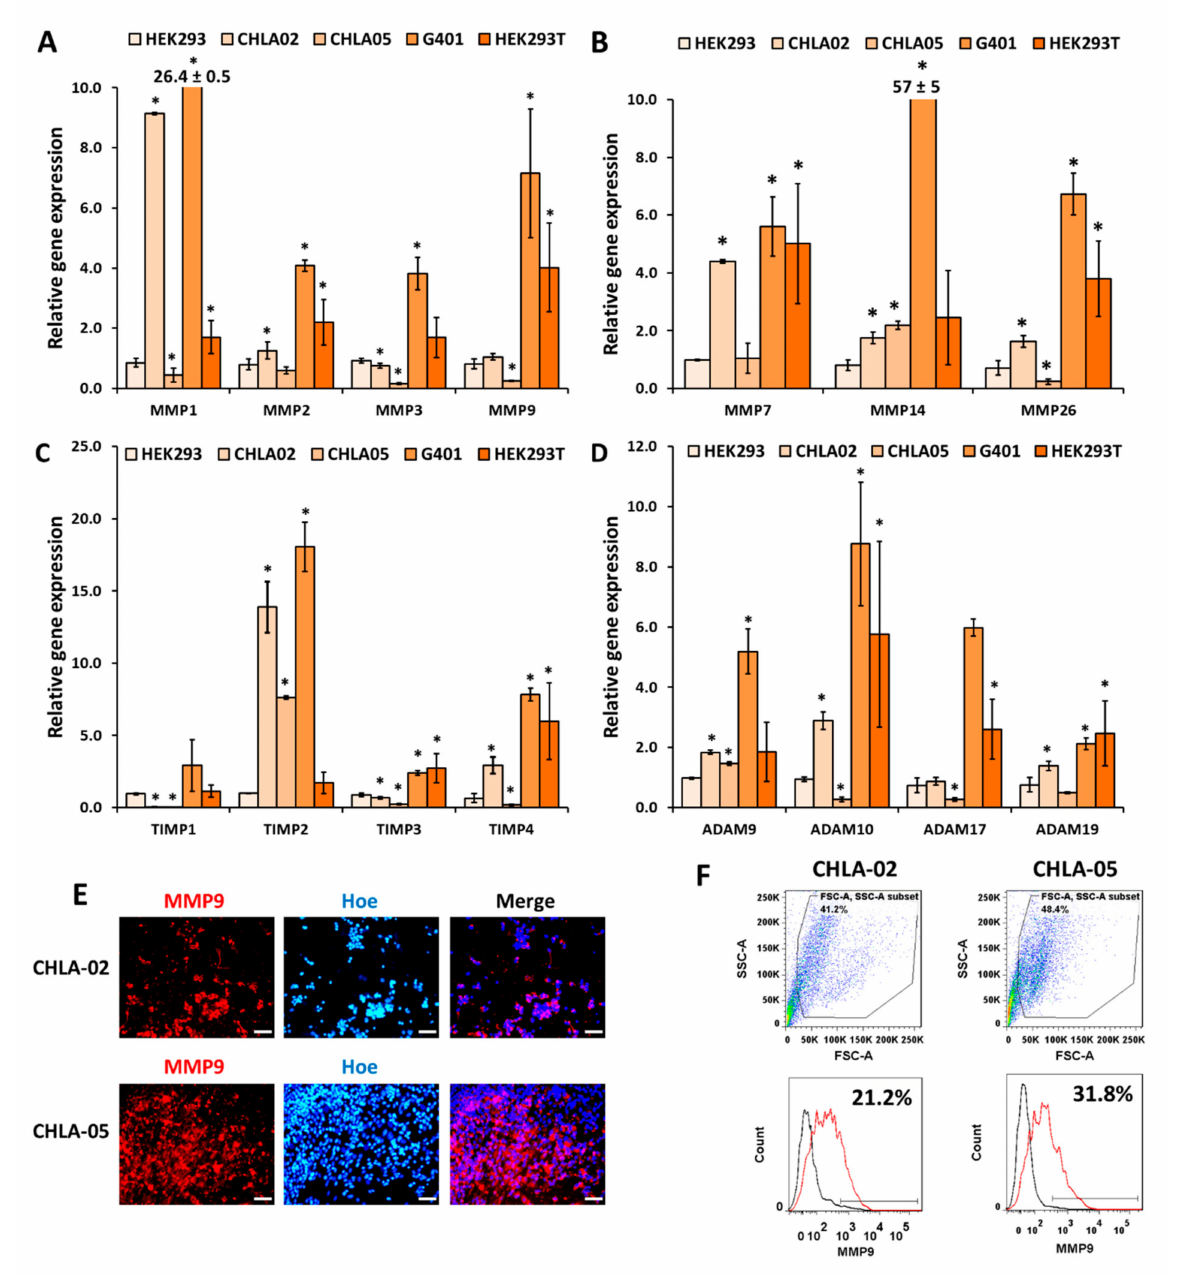
Figure 3. Cellular expression of various MMPs, TIMPs, and ADAMs. ( A , B ) Gene expressions of ( A ) MMP1, 2, 3, 9 ; ( B ) MMP7, 14, 26 ; ( C ) TIMP1, 2, 3, 4 ; ( D ) ADAM9, 10, 17, and 19 . *: p -value < 0.05 when compared to HEK293 cells using the Student’s t -test. ( E ) Immunostaining for MMP9. Scale bar: 100 µ m. ( F ) Flow cytometry analysis of MMP9 expression in CHLA-02 and CHLA-05. Black line: isotype control; red line: the marker of